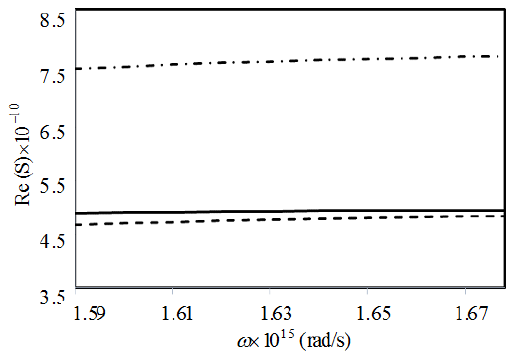
Fig. 3 Real part of the sensitivity for TE 0 versus frequency with 6 =6.089 10    Siemens at different values of d . Dash line is when d = 85 nm, solid line is when d = 75 nm, and dash-dotted line is when d = 55